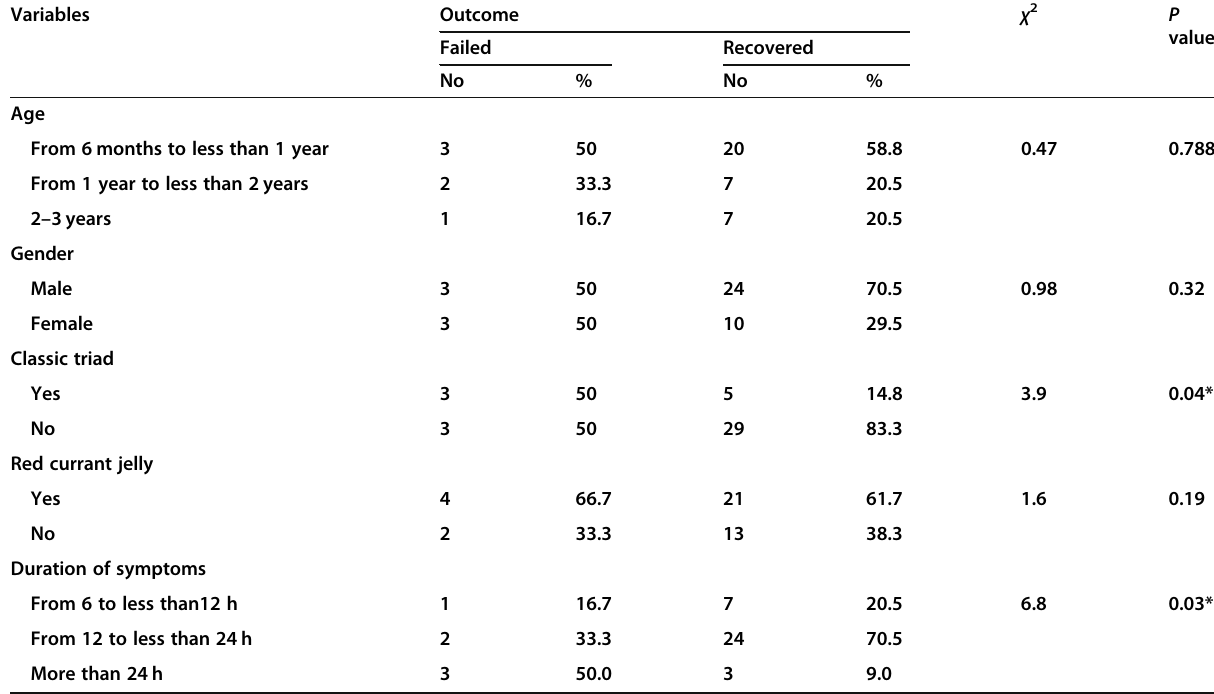
Table 2 Effect of different variables on outcome Variables